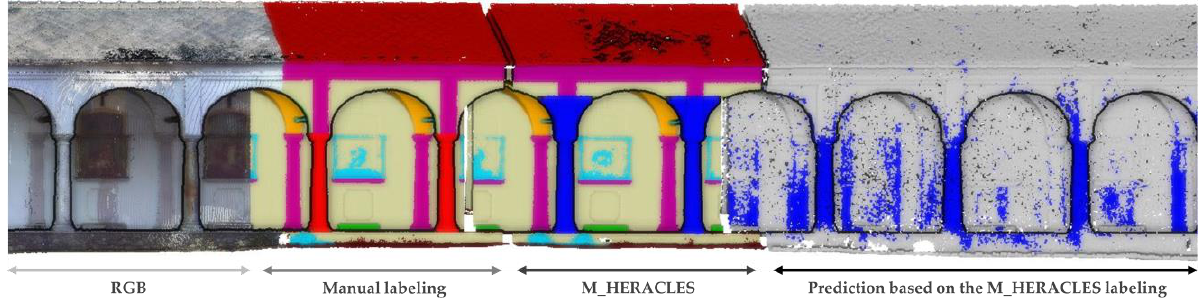
Figure 7. From left to right: detail of the point cloud in RGB, manual annotation of the columns, automatic annotation and finally the prediction results. Notice how the upper mouldings labelled as columns by M_HERACLES are very similar to the engaged columns on the wall